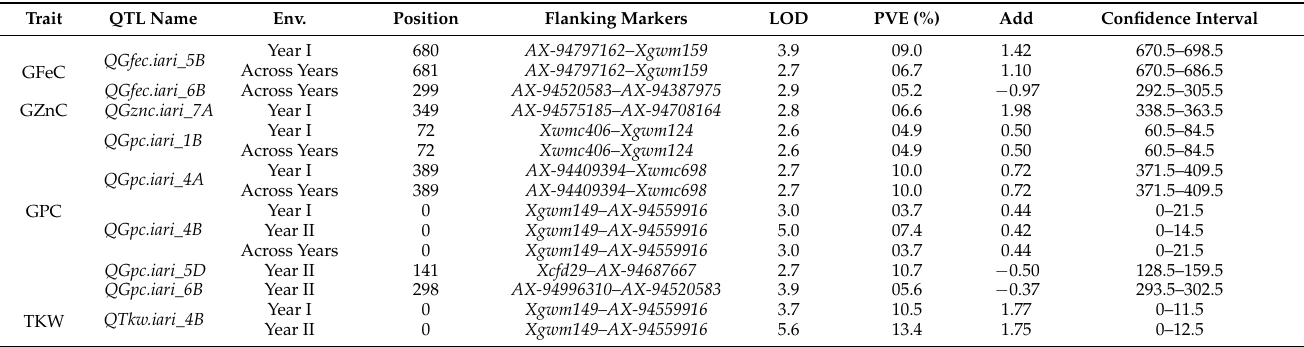
Table 2. List of QTLs identified for GFeC, GZnC, GPC, and TKW.